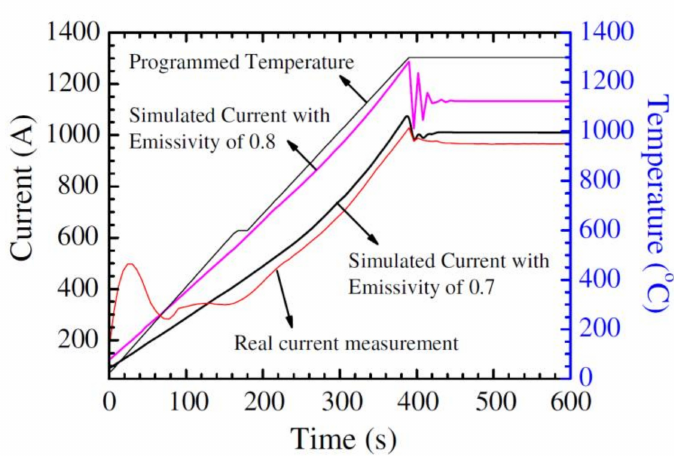
Figure 2. Modeled and measured input currents for a given programmed temperature profile as a function of the emissivity (Stefan–Boltzmann law) used for the graphite die. With an emissivity of 0.7, reasonable equivalence is given between the experimental and simulated currents. At low temperature, current densities di ff er more broadly due to the experimental pyrometer limitations at low temperatures [48]. (reprinted with permission from